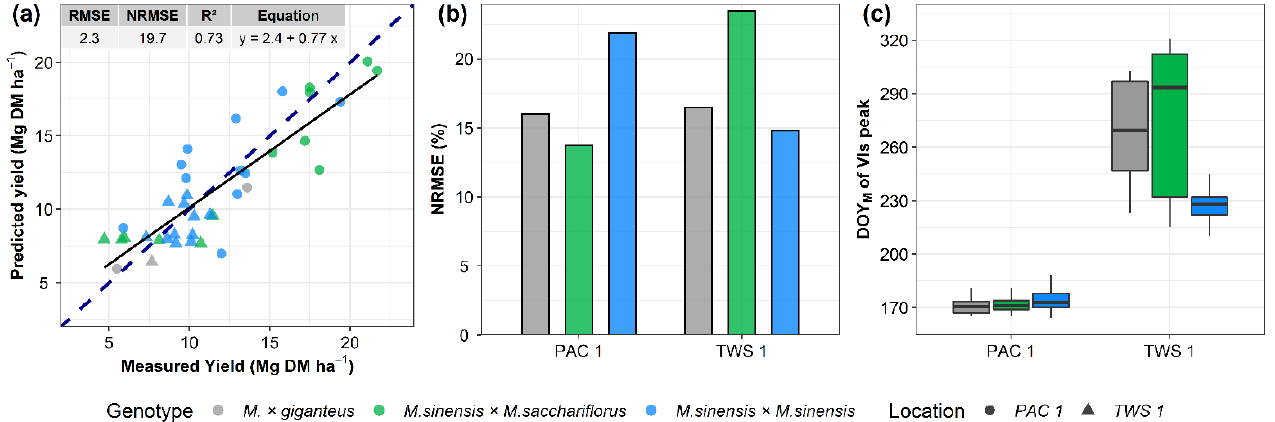
Figure 8. The ( a ) predicted vs. measured yield (Mg DM ha − 1 ), ( b ) NRMSE of the RF model for yield prediction, and ( c ) boxplot of the modified days of the year (DOY M ) of the peak derived from the complete time series of the 5 VIs (greenWDRVI, GNDVI, MTVI2, NDVI, and WDRVI,) of different Miscanthus hybrids, at two locations, PAC 1 and TWS 1.